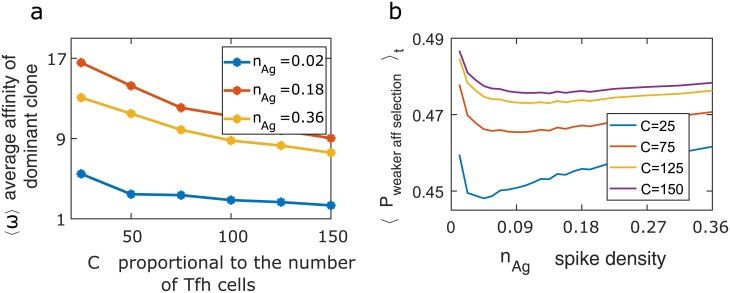
Effect of T helper cell level and spike density on affinity maturation.(a) The average affinity of the dominant clone in a GC increases for viruses exhibiting a high spike density as Tfh levels (C) decline. Different curves correspond to different values of spike density (nAg). EAg−Ab changes upon mutation in these simulations. (b) The probability of selecting the wrong B cell (see text) is shown for different values of C. The probability shown is a time average over all GCR days.